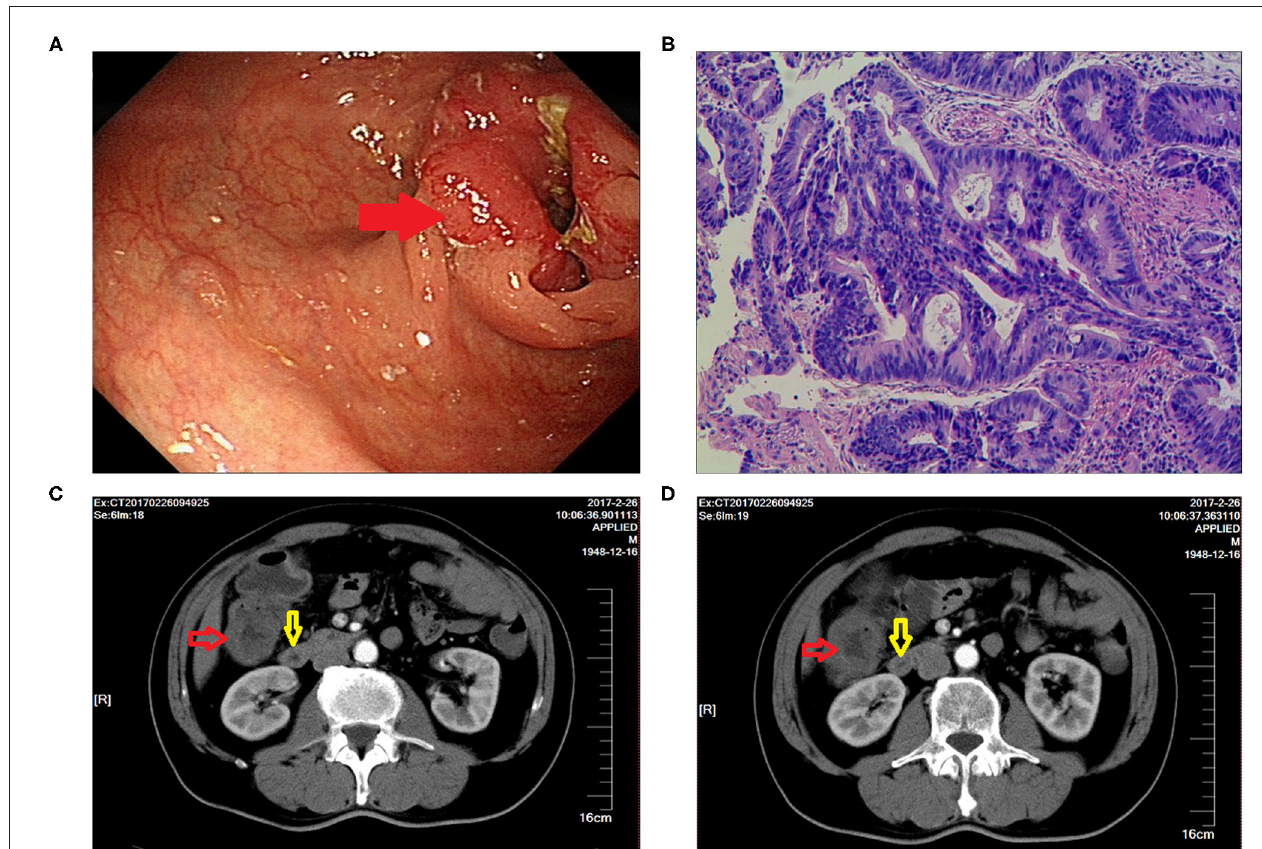
FIGURE 1 | Imaging findings for right hemicolectomy performed 4 years ago. (A) Colonoscopy showed the presence of a colonic tumor (indicated by the red arrow). (B) H&E staining was indicative of adenocarcinoma. (C,D) CT showed a tumor of hepatic flexure of colon that did not invade the duodenum (the red arrow indicates the tumor, and the yellow arrow indicates the